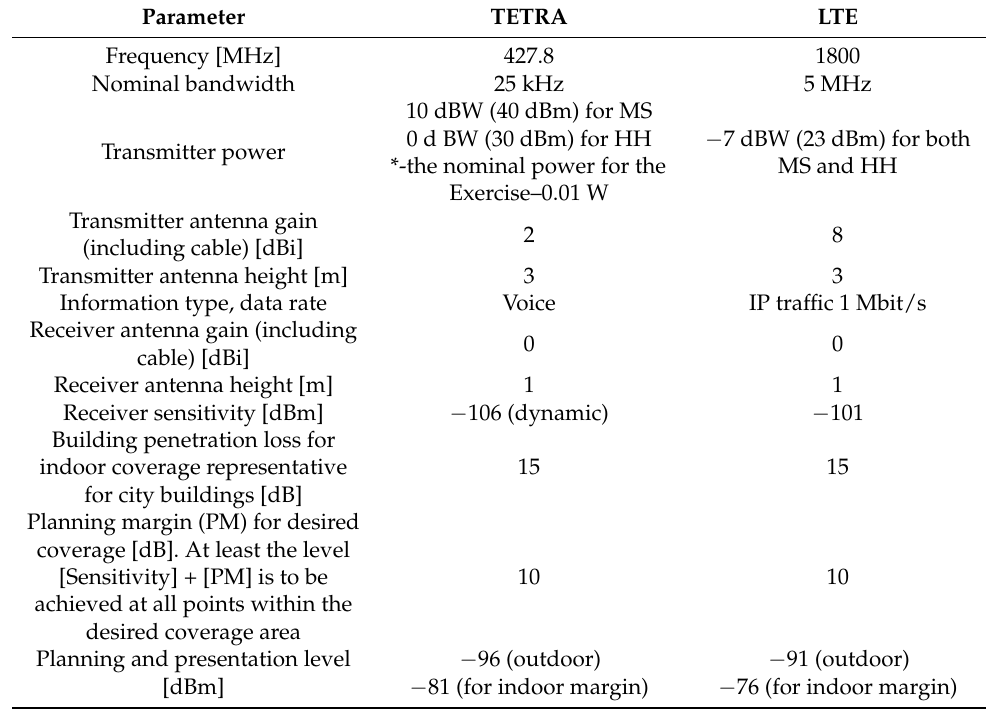
Table 2. Planning Rx/Tx parameters.